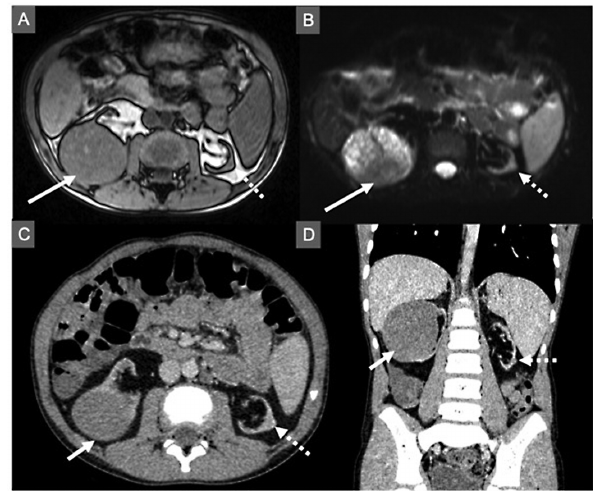
Fig. 1 Cross-sectional imaging of the patient ( arrow : right renal mass; broken arrow : left renal mass). ( A ) Out-of-phase T1 magnetic resonance sequence shows absence of fat. ( B ) Diffusion-weighted T2 magnetic resonance sequence shows restricted diffusion. ( C, D ) Contrast enhanced axial and coronal computerized tomography images show contrast uptake by both